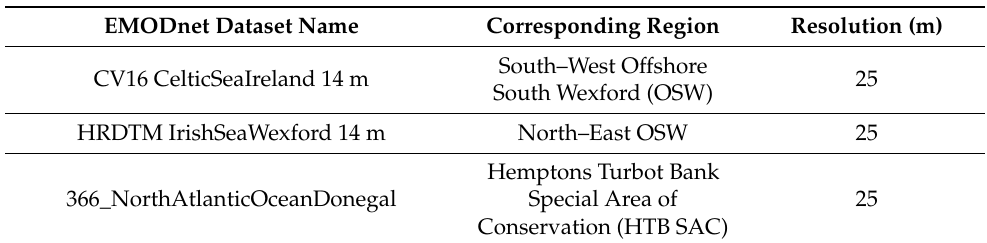
Table 1. Datasets acquired from the EMODnet bathymetry data portal, including the original name of each file as designated on the EMODnet bathymetry data portal